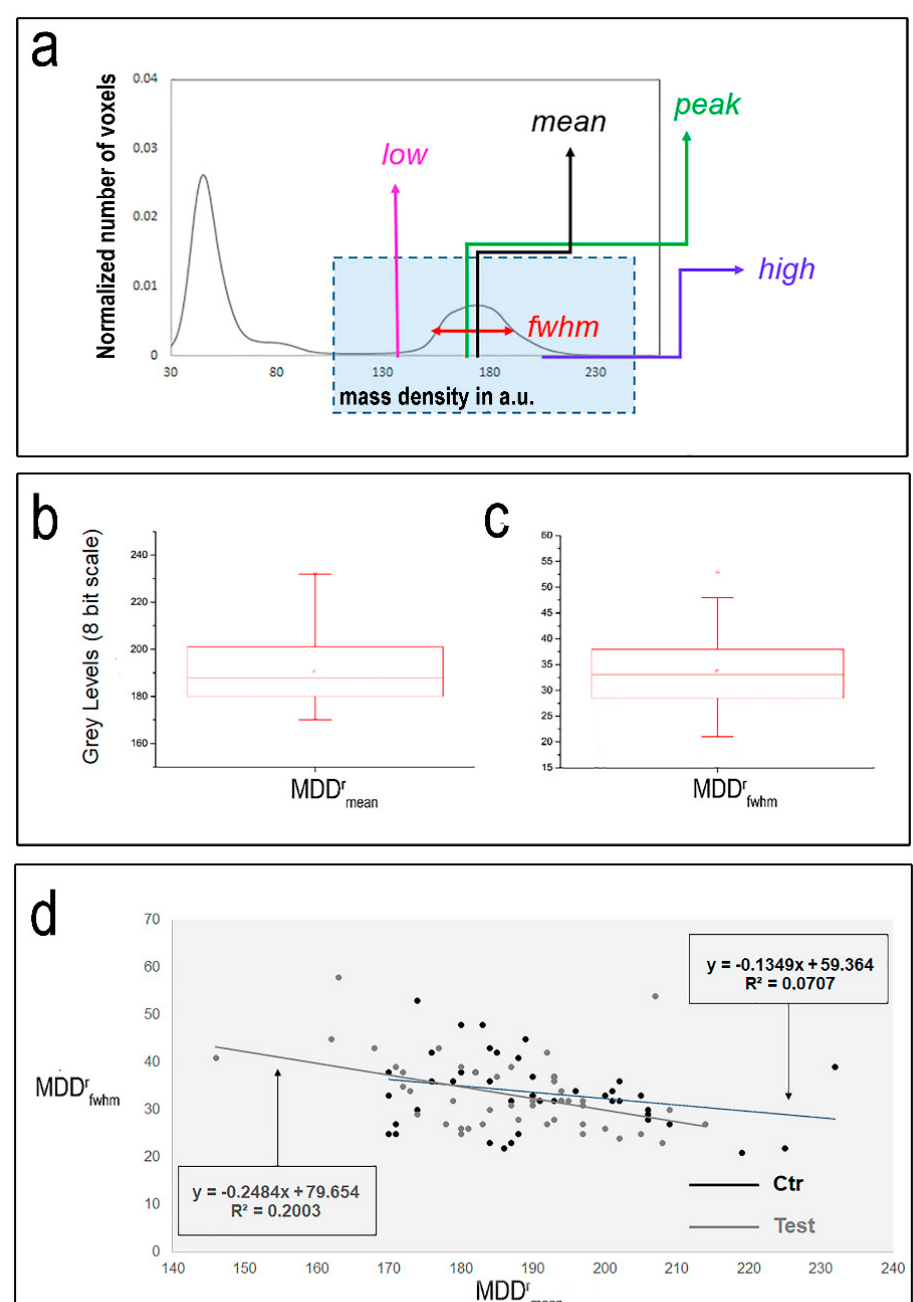
Figure 2. Parameters of interest for the analysis of bone relative mass density distribution (MDD r ). ( a ) Histogram of a representative sample: the peak on the right, highlighted in translucent blue, was referred to the overall mineralized bone that was regenerated into the defect. The parameters investigated with the Roschger approach are indicated. ( b – d ) Study of the sensitivity of the Roschger approach: box plots of the distribution ( b ) of the mean relative mass density (MDD r mean ) and ( c ) of the full width at half maxima of the distribution (MDD r fwhm ) in the whole set of ctr sites (i.e., in the calvaria but outside the defect); ( d ) dispersion graphs describing mean vs. fwhm dependency, the two regression equations and their coefficient of determination R 2 for the full sets of ctr and test data.